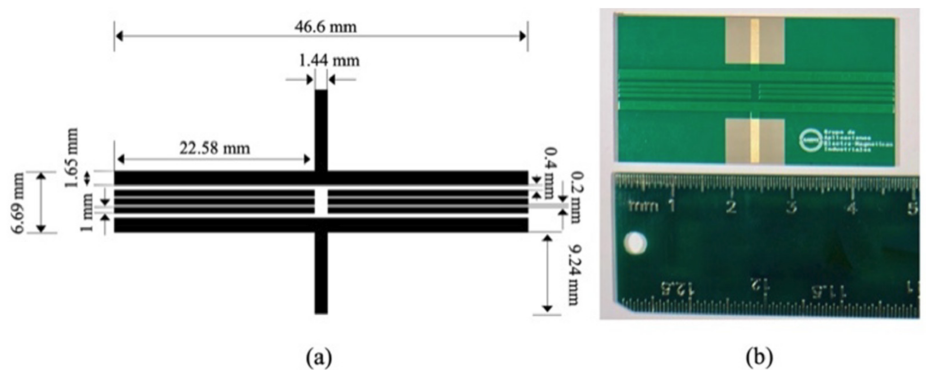
Figure 2. ( a ) Layout of the MIMN microstrip top layer with the physical dimensions: length l = 22.8 mm, coupled stubs width w = 6.69 mm, inter coupled stubs gap g = 0.2 mm, and gaps to the input and output ports gp = 0.4 mm. ( b ) Image of the fabricated prototype.